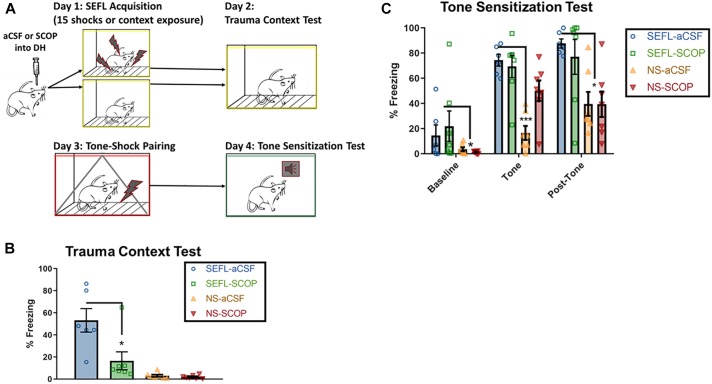
SEFL Tone Procedure and Tone Sensitization Test. (A) SEFL Tone Procedure. Schematic representation of the stress-enhanced fear learning procedure, which in the SEFL group produces both high levels of fear in the trauma context as well as sensitization to a new tone paired once with shock. (B) Trauma test after SEFL. In this cohort, we replicated our initial finding in the Trauma Test, namely that scopolamine attenuated freezing to the SEFL context. (C) Tone Sensitization after SEFL. After a tone shock pairing, there was some generalization to the tone-test context in both SEFL groups, but fear levels were low before tone onset. During the tone and in the post-tone period, all SEFL rats show elevated fear compared to rats that did not receive SEFL. These data indicate that while scopolamine into DH protects against future sensitization to contexts, it does not protect against future sensitization to tones (n = 6 or more per group). All individual data shown, error bars indicate SEM.